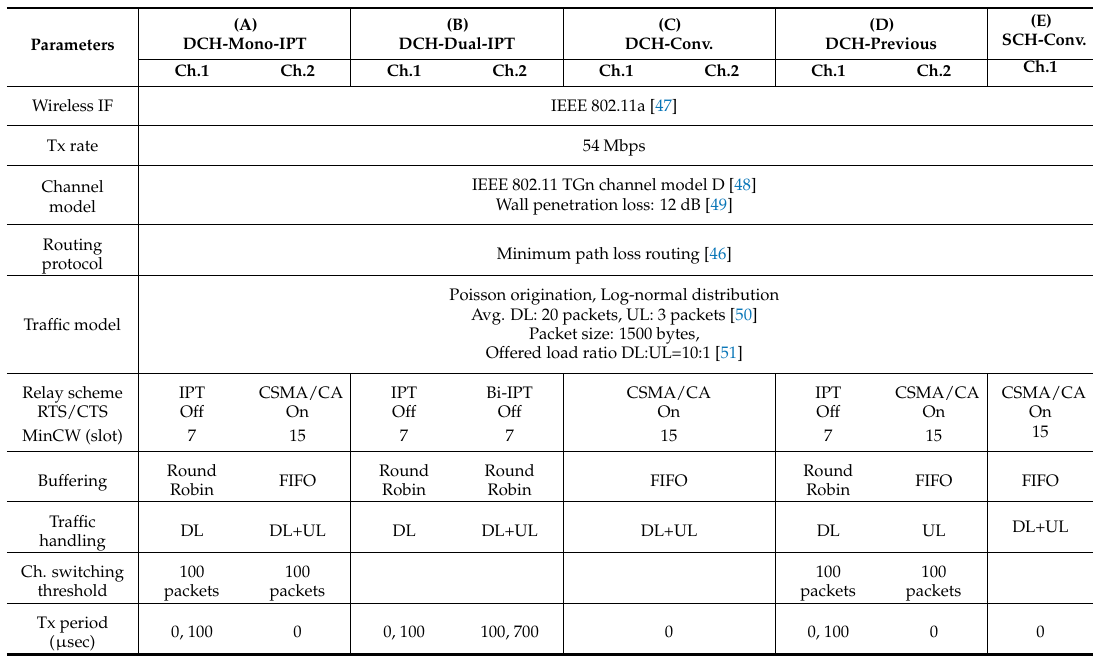
Table 1. Simulation